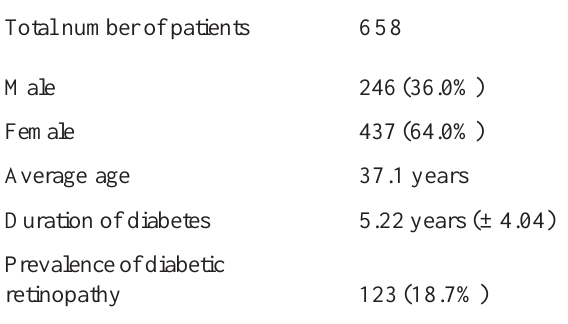
Table 1. Demographic characteristics of the patients